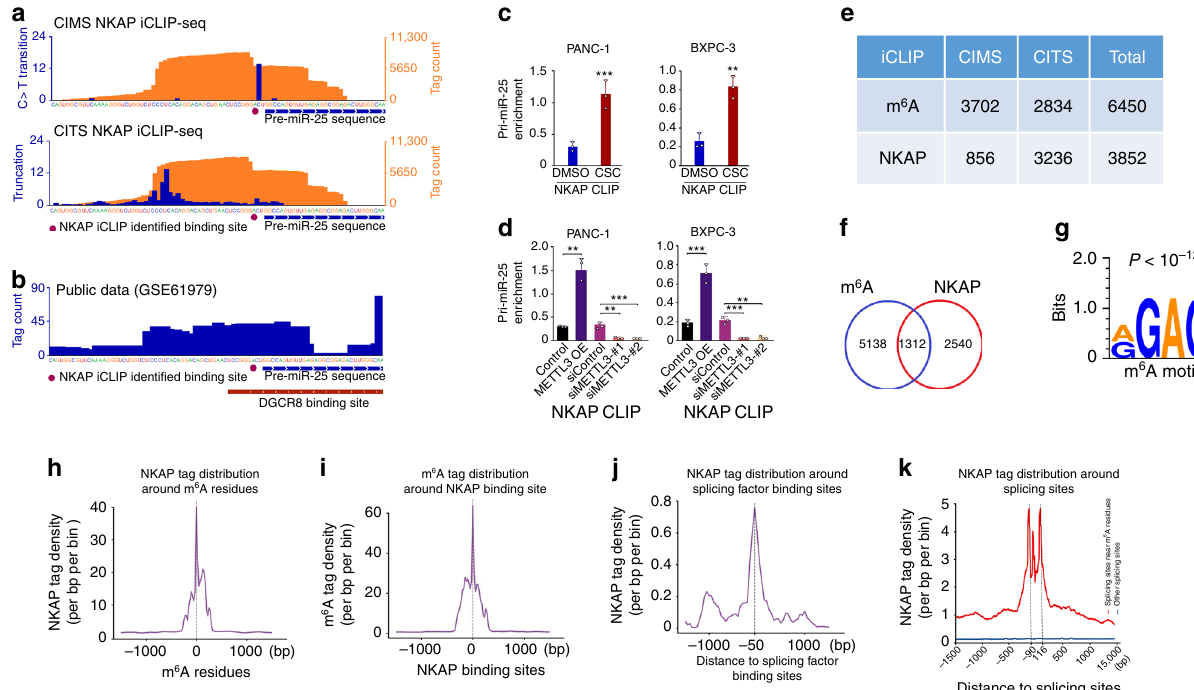
Fig. 5 NKAP is a reader of m 6 A on pri-miR-25. a The NKAP-binding sites on pri-miR-25 detected by CIMS and CITS miCLIP-seq. Orange tracks of NKAP- iCLIP-seq are unique tag coverage and blue tracks represent C>T transition and truncation, respectively. Filled purple circles denote iCLIP-called NKAP- binding site and the horizontal blue bars indicate the transcript model of pre-miR-25. b The DGCR8-binding sites on pri-miR-25 detected by DGCR8 HITS- CLIP. Filled purple circles denote iCLIP-called NKAP-binding site and the horizontal blue and red bars represent the transcript model of pre-miR-25 and the DGCR8-binding site, respectively. c In vivo binding of NKAP-FLAG to pri-miR-25 in PDAC cells exposed to CSC or DMSO detected by CLIP-qPCR. Values are the mean ± S.D. from three independent experiments. d The levels of NKAP-FLAG bound to pri-miR-25 were signi fi cantly elevated by overexpression of METTL3 , but signi fi cantly decreased by knockdown of METTL3 in both PANC-1 (left panel) and BXPC-3 (right panel) cells. Values are the mean ± S.D. from three independent experiments. e Data of m 6 A residues and NKAP-binding sites identi fi ed by the analysis of cross-linking-induced mutation sites (CIMS) or cross-linking-induced truncation sites (CITS) in iCLIP-seq data. f Venn diagram showing overlap between m 6 A residues and NKAP-binding sites. g Signi fi cant enrichment of RGAC motif is in NKAP footprints (CIMS or CITS along with 5-nucleotide fl anking sequences) analyzed by MEME SUIT with default parameters. h Shown is the intensity of NKAP binding centered at m 6 A residues. i Shown is the intensity of m 6 A CLIP signal centered at NKAP- binding sites. j Shown is the distribution of NKAP iCLIP tag density around the splicing factor binding sites. k Shown is the binding intensity of NKAP at splicing sites near or not near m 6 A residues. All statistic examinations in this fi gure are Student t test unless speci fi c. * P < 0.05, ** P < 0.01, and *** P < 0.001 compared with the corresponding